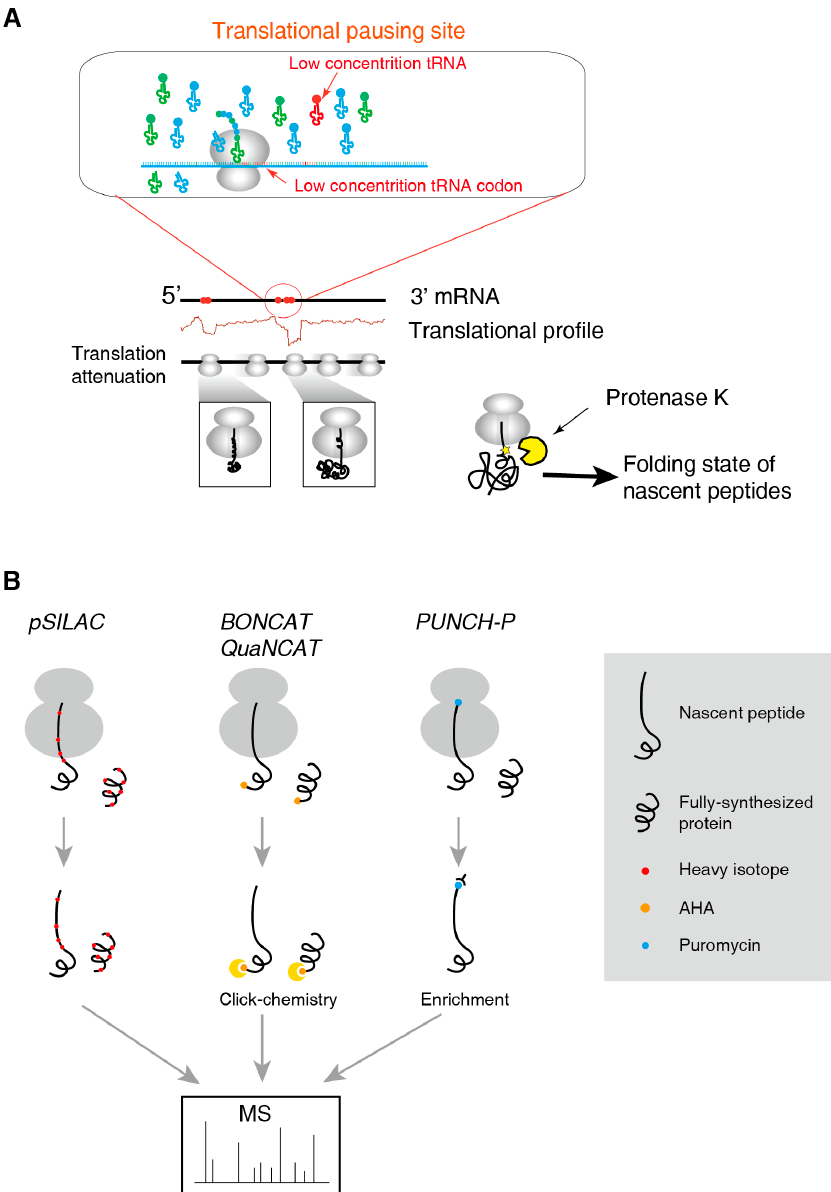
Figure 2. The major methods to investigate nascent peptides. ( A ) Translational pausing sites and the co-translational folding of nascent peptides. Proteinase K limited digestioni is often used to detect the folding state of nascent peptides. ( B ) High-throughput methods to identify and quantify nascent peptides.